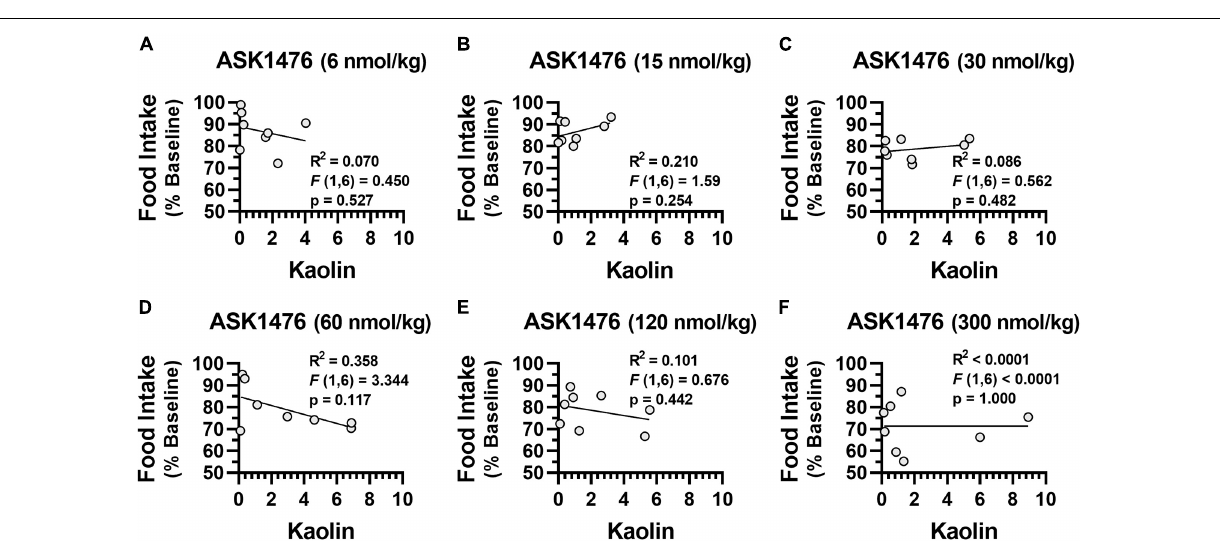
Frontiers in Physiology |